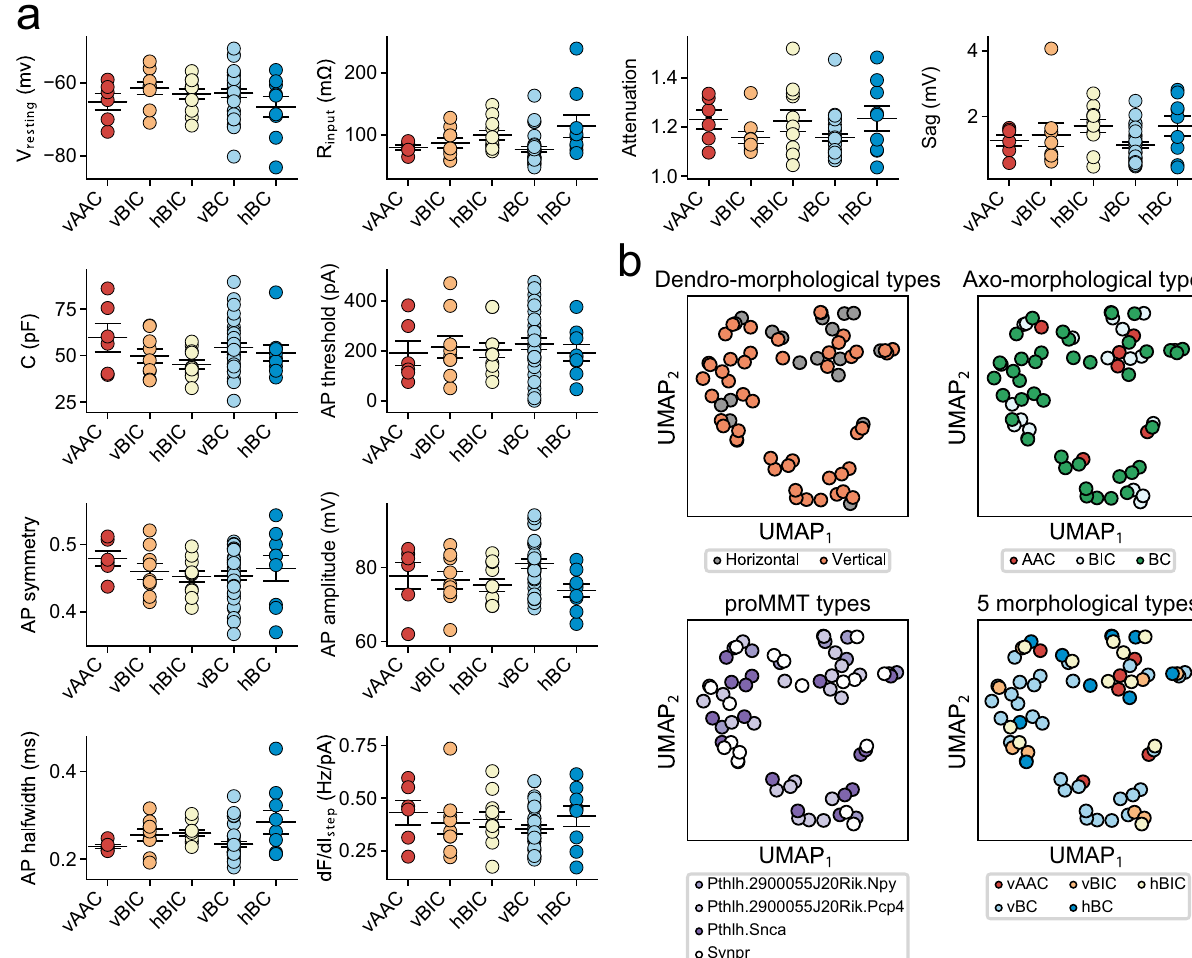
Fig. 3 Electrophysiological properties of PV-INs. a Plots show electrophysiological properties measured in the fi ve morphological PV types. Circles represent single cells. Data represent mean ± S.E.M. b All panels show dimension reduction on electrophysiological data using UMAP. Circles represent single cells and are colored to show the two dendro-morphological (horizontal and vertical), three axo-morphological (AAC, BIC, and BC), four proMMT transcriptomic (Pthlh.2900055J20Rik.Npy, Pthlh.2900055J20Rik.Pcp4, Pthlh.Snca, and Synpr), and fi ve morphological (vAAC, vBIC, hBIC, vBC, and hBC) PV